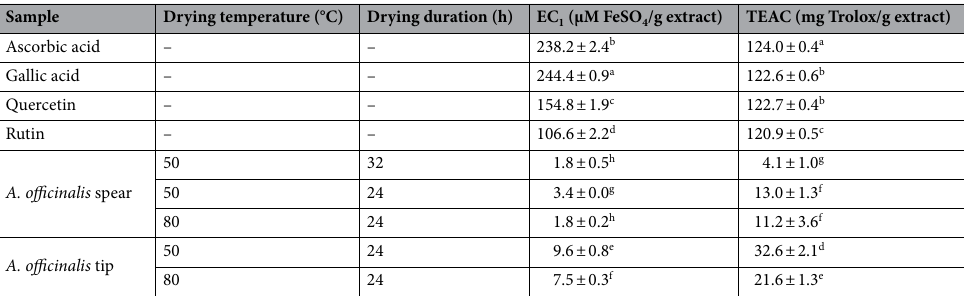
Table 2. Antioxidant activities of A. officinalis extracts. Data presented as mean ± SD (n = 3). Different letters, a, b, c, d, e, f, g, and h, denote significant differences in antioxidant activities among various A. officinalis extracts, whereas similar letters denote non-significant differences at p <